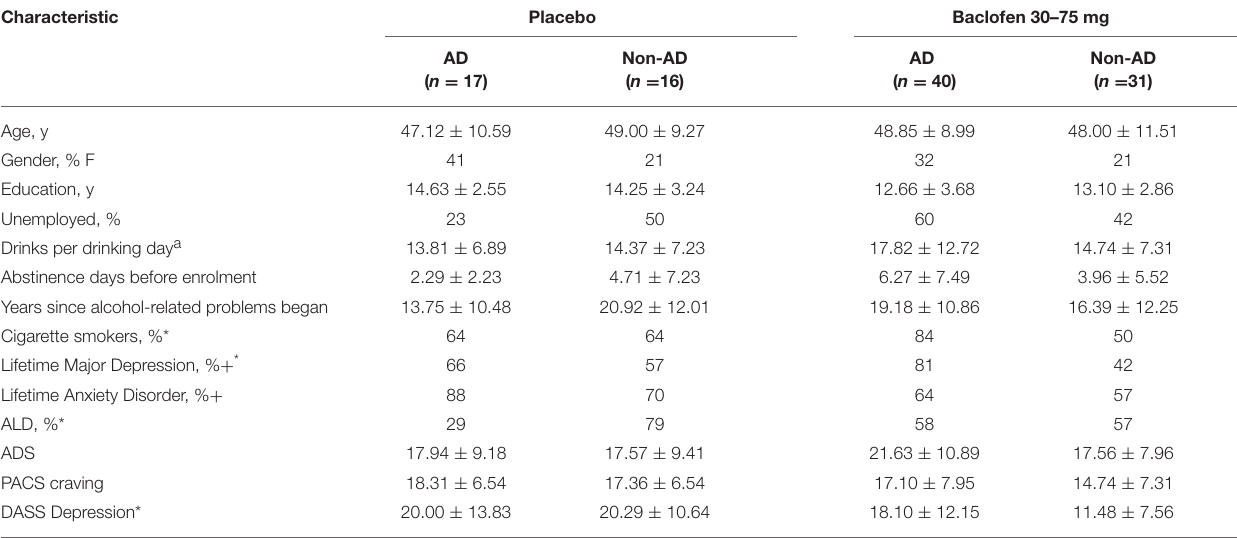
TABLE 2 | Intention to treat: Baseline characteristics of patients according to concurrent antidepressant use. Characteristic Placebo Baclofen 30–75 mg